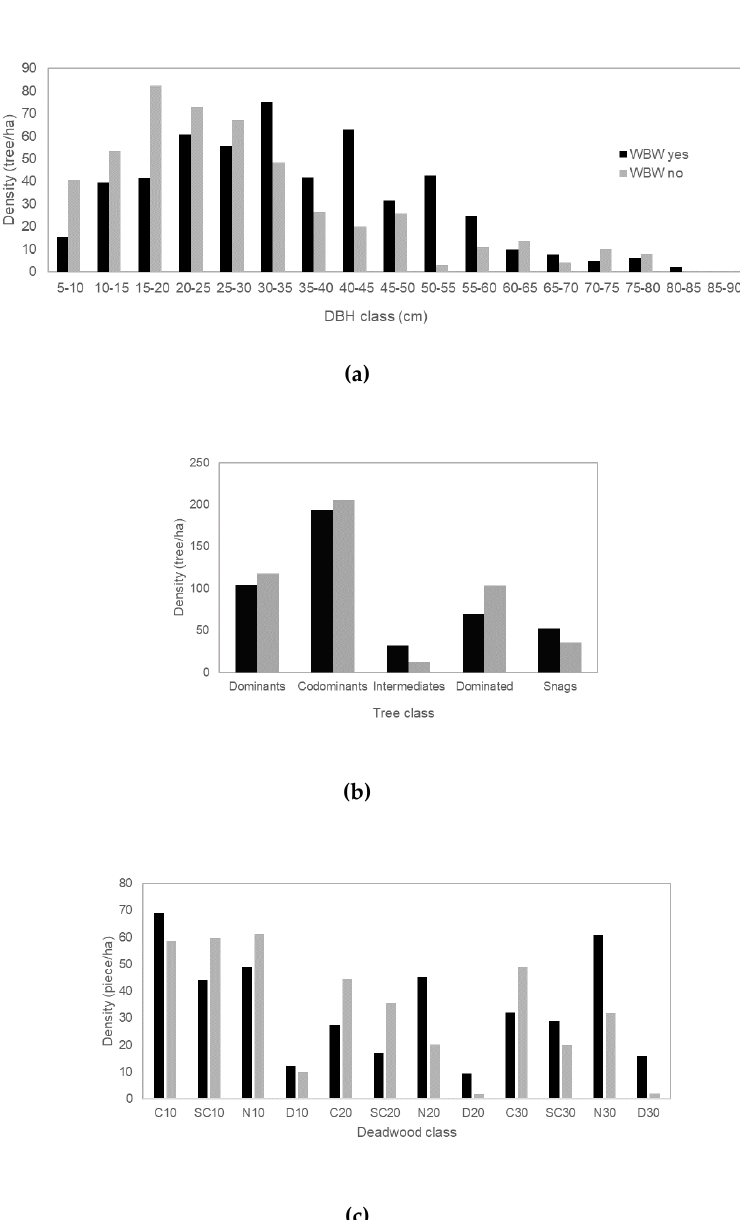
Figure 3. Bar chart of the distribution of diameter at breast-height (DBH) classes ( a ), tree classes ( b ), and deadwood classes ( c ) in WBW territories (“WBW yes”, black) and non-WBW territories (“WBW no”, grey). Deadwood classes are defined by letters indicating the decomposition state (C = with bark, SC = without bark, N = in a state to be cut with a knife, D = in a state to be broken with the fingers) and the diameter (10, 20, or 30 cm).